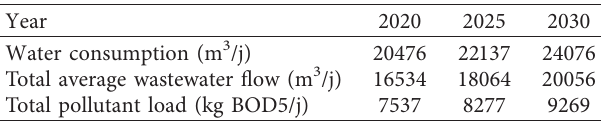
Figure 1: Taza City geographic location (source: Google Earth). Table 1: Estimates of flows and pollutant loads (Taza City liquid sanitation study